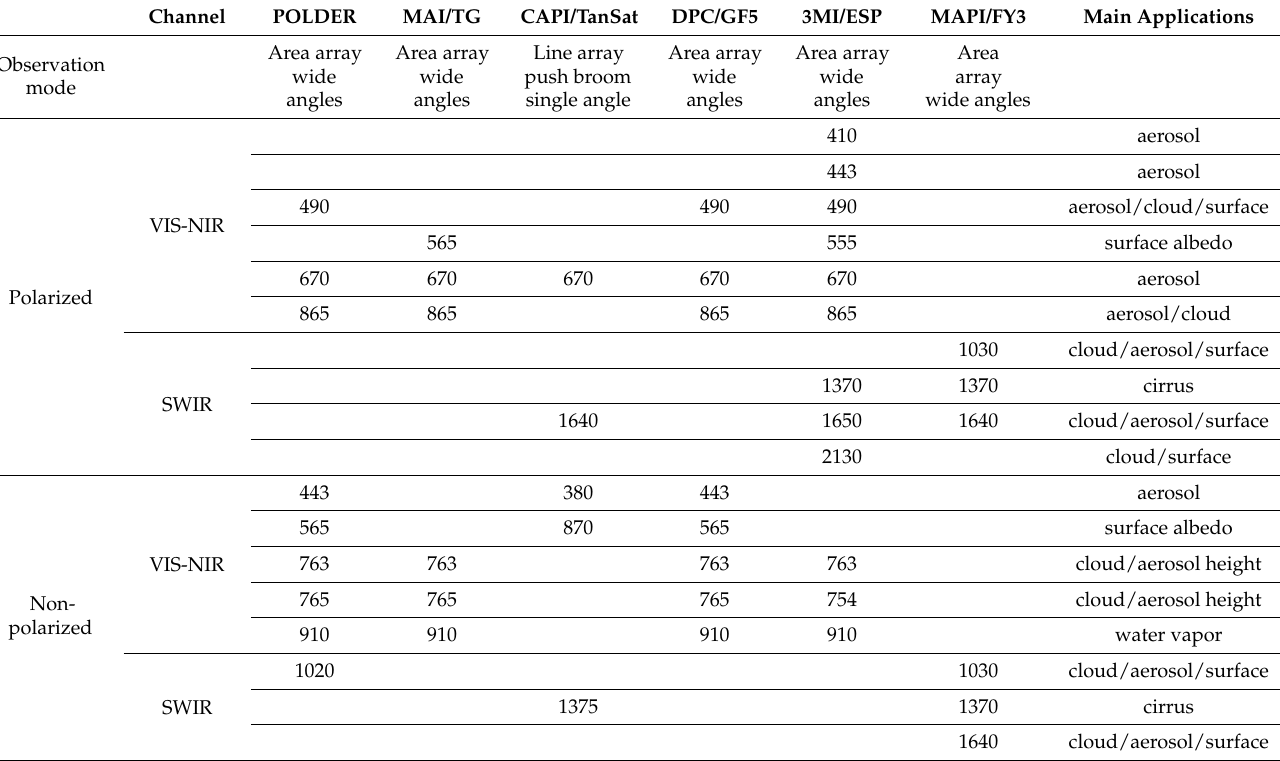
Table 1. Overview of launched and completed polarization